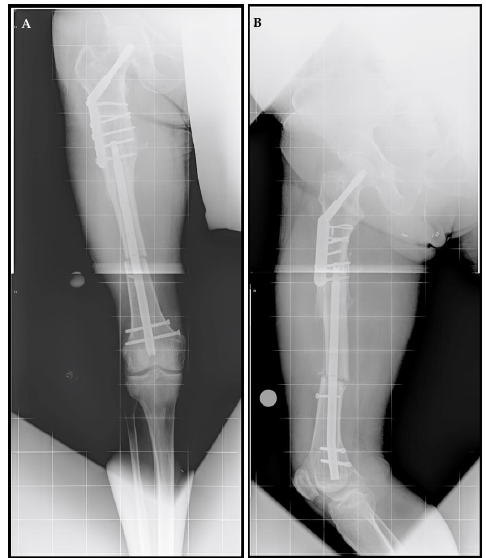
Figure 2. Post-traumatic femoral lengthening in a 71-year-old male patient, shown here postopera- tively. ( A ) Anteroposterior and ( B ) lateral of the right femur after osteoplasty and the insertion of the Precice MILN. Gray dots on the bottom represent X-Ray calibration spheres. J. Clin. Med. 2022 , 11 , x FOR PEER REVIEW